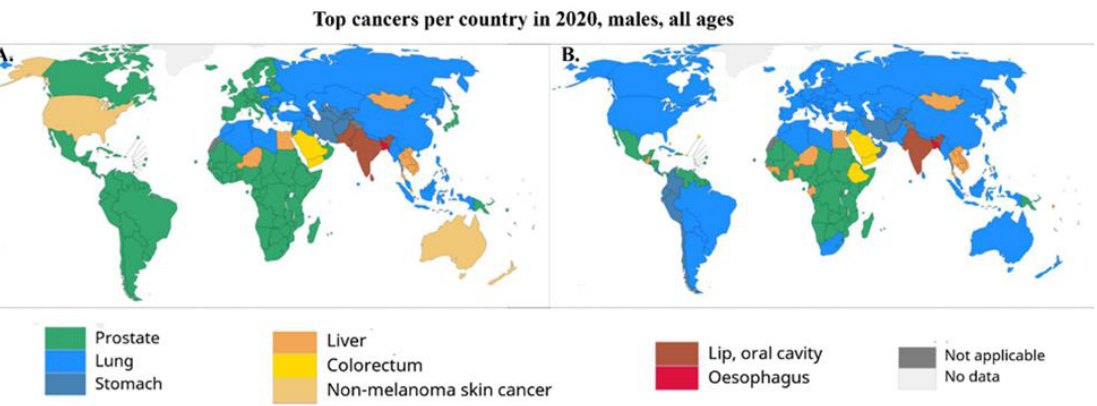
Figure 1. ( A ) Most diagnosed types of cancer among men worldwide, 2020. Nonmelanoma skin cancer was included in calculations of top cancer per country. ( B ) Leading cause of cancer deaths among men worldwide, 2020. Source: GLOBOCAN 2020 [1].